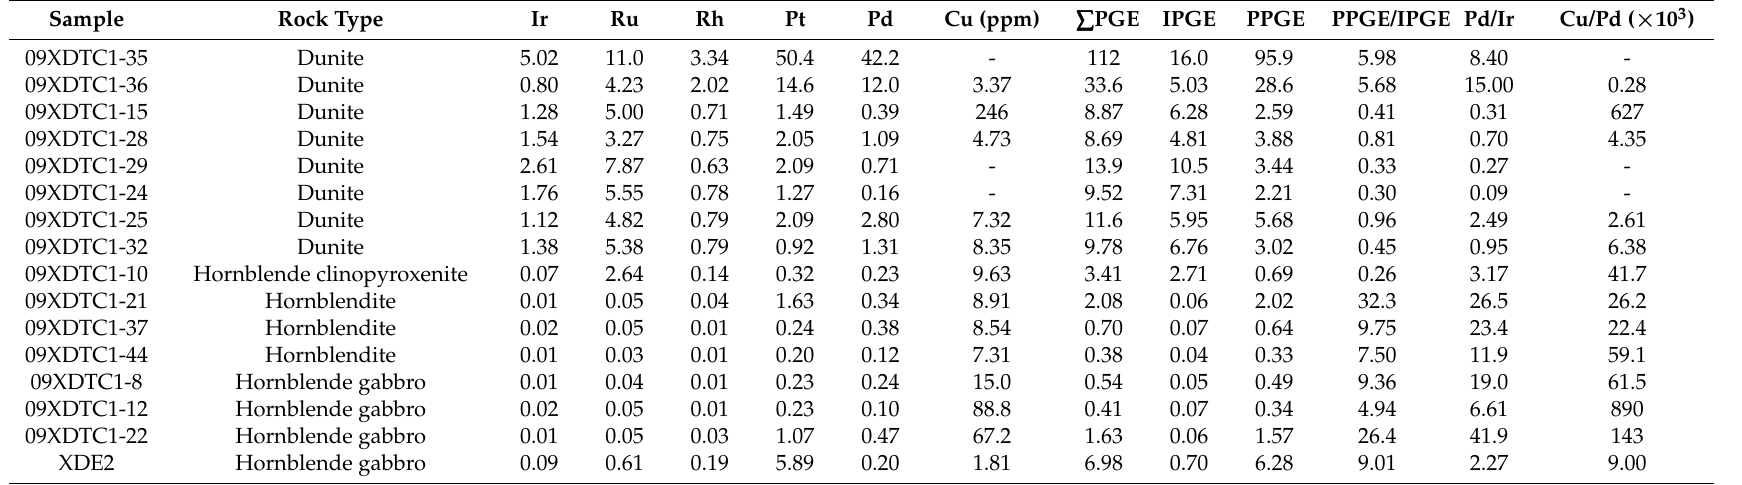
Platinum-group element (PGE) concentrations (ppb, except where specified) of the rocks from the Xiadong Alaskan-type complex. PPGE—Pd–PGE;